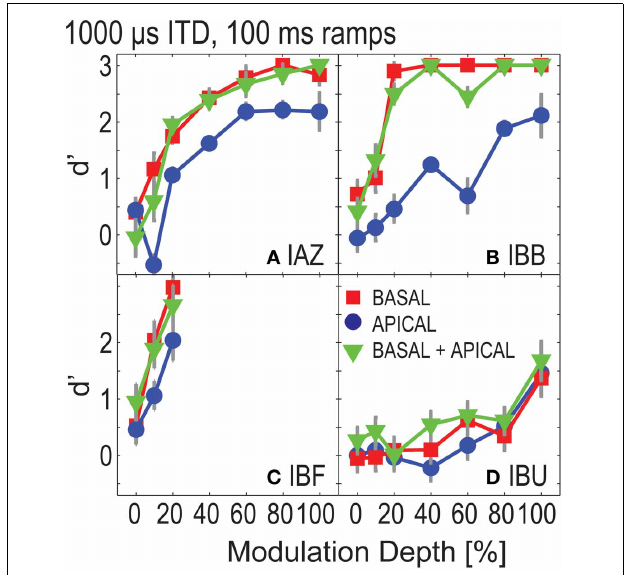
FIGURE 3 | ITD sensitivity as a function of modulation depth for ramped stimuli in Experiment 2. Each panel (A–D) shows results for one listener. Basal-only, apical-only, and dual-site electrode configurations are shown by the different